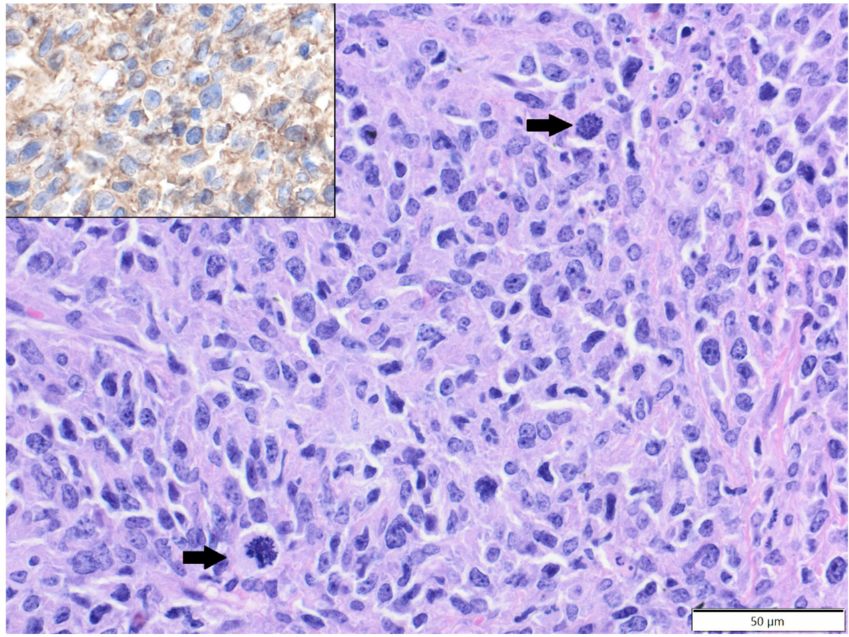
Figure 1. Histiocytic sarcoma, submandibular area, rat. Pleomorphic tumour cells are arranged haphazardly and show mitotic figures (arrows). HE. Inset: tumour cells express Iba-1.